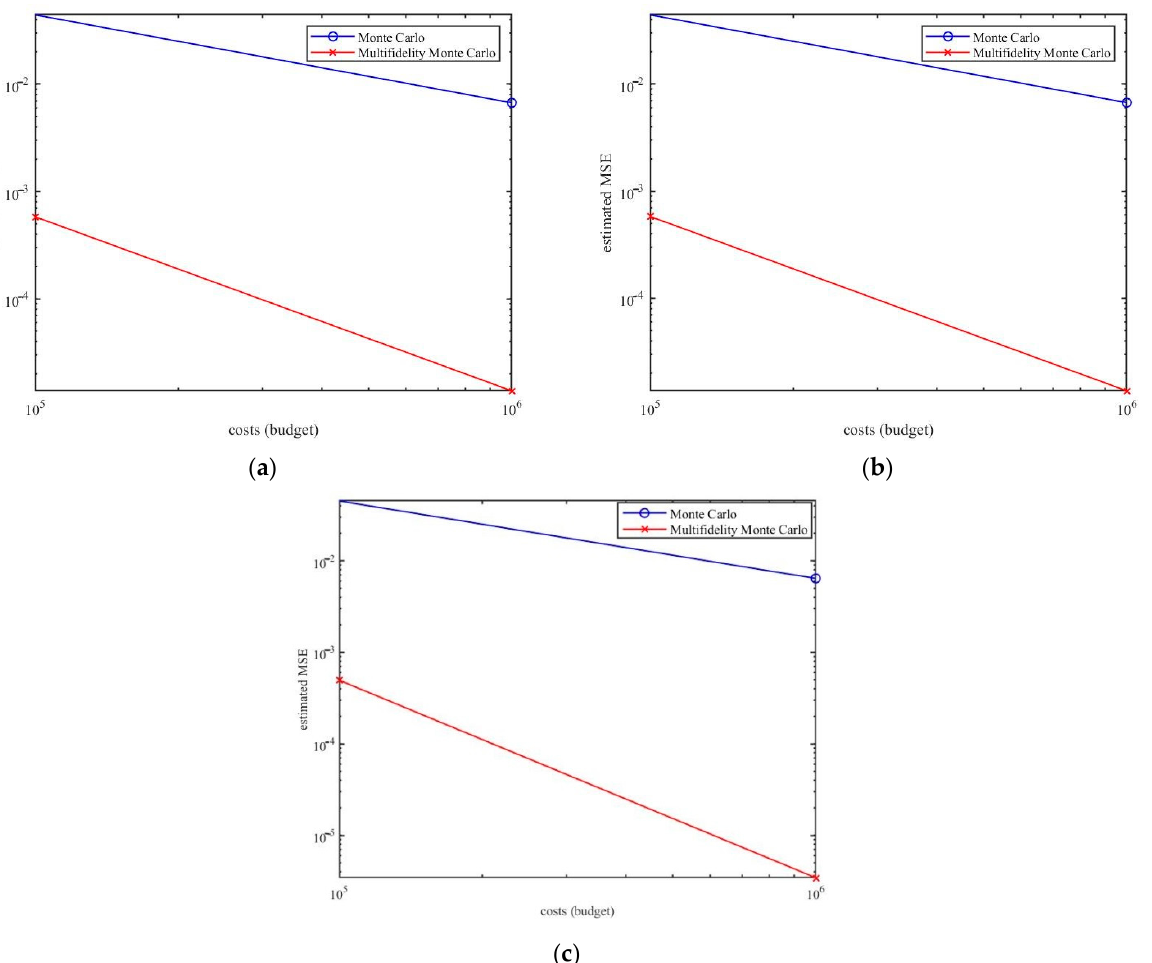
Figure 5. The estimated MSE of the standard MC estimators and the MFMC estimators of budgets = from 5 10 p to 6 10 . ( a ) MSE estimation of f ( 1 ) , f ( 2 ) . ( b ) MSE estimation of f ( 1 ) , f ( 3 ) . ( c ) MSE estimation of f ( 1 ) , f ( 2 ) , f ( 3 ) .